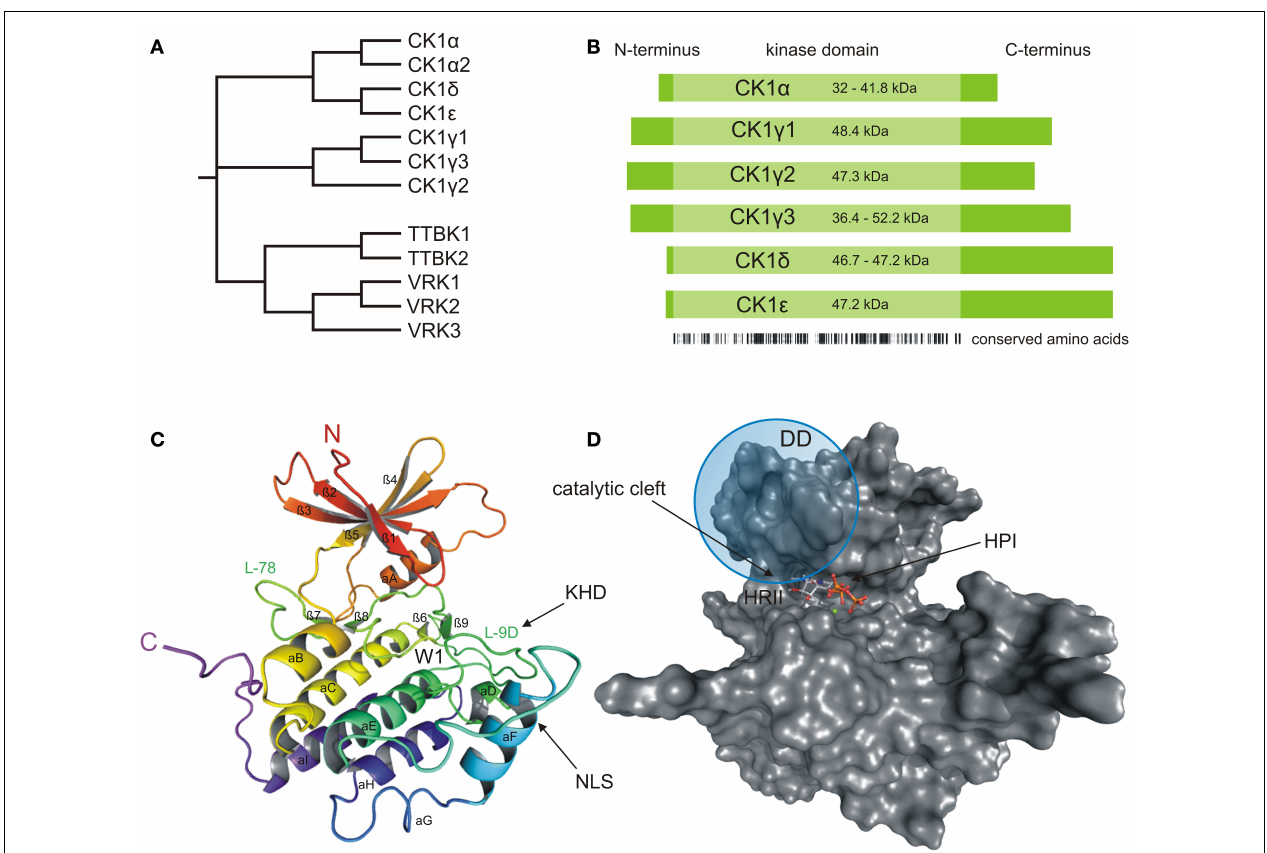
4HOK) are accessible as well. For reasons of clarity, we focused on CK1 δ exemplarily, due to its superior relevance.The catalytic domain folds into two lobes primarily containing strands (N-terminal), respectively helices (C-terminal) forming a catalytic cleft between that represents the ATP binding pocket as well as a substrate binding site. KHD indicates the kinesin homology domain within L-9D. DD refers to a putative dimerization domain containing various amino acids of β 1, β 2, β 5, L-5B, β 7, and α B, whereas NLS displays a putative nuclear localization signal sequence at the junction between L-EF and α F. A tungstate molecule binding site identifies a specific phosphate moiety binding motif (W1).The active site contains a deep hydrophobic pocket (HPI) and a spacious hydrophobic region (HRII) (25–28). All modeling and docking studies were performed using